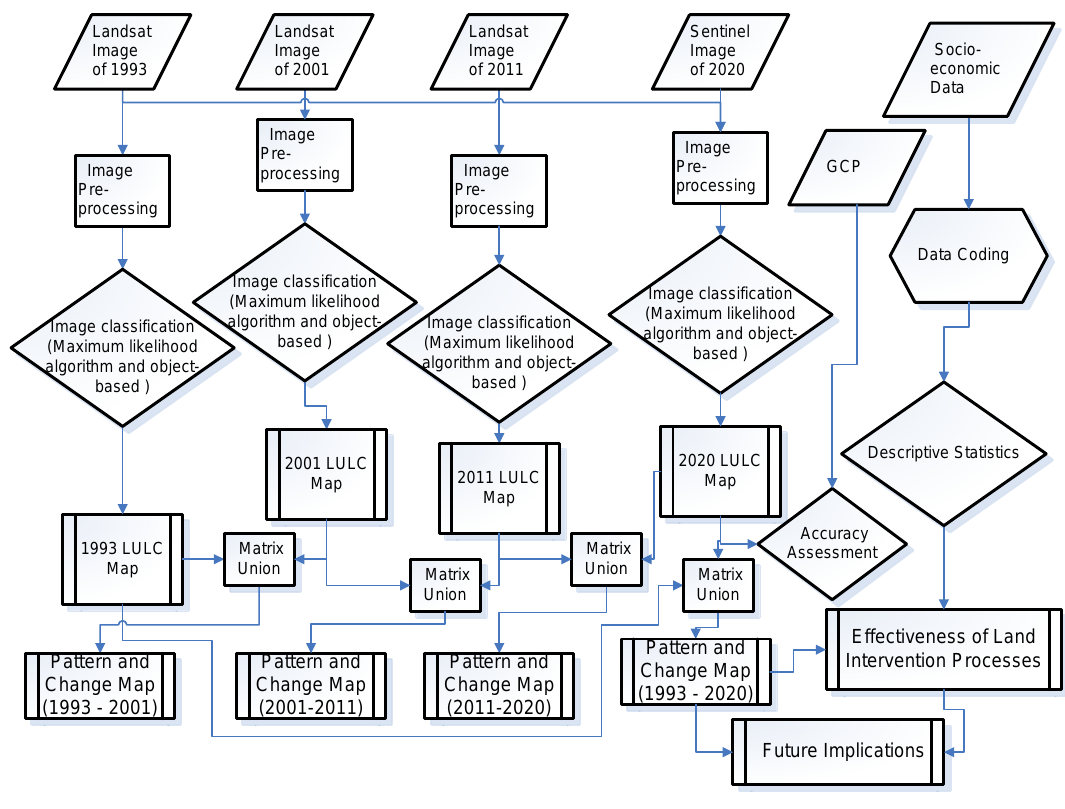
Figure 4. Methodological framework.